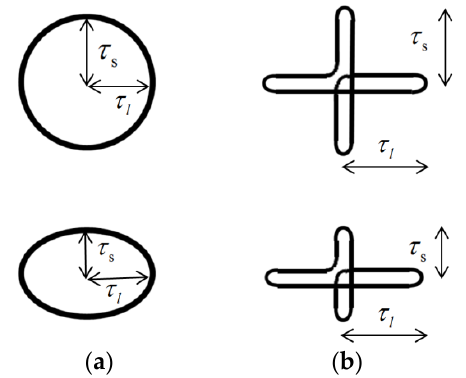
Figure 3. Stress paths in the bi ‐ directional simple shear tests ( a ) rotational loadings and ( b ) alternate shear loadings (Reprinted from [29]).